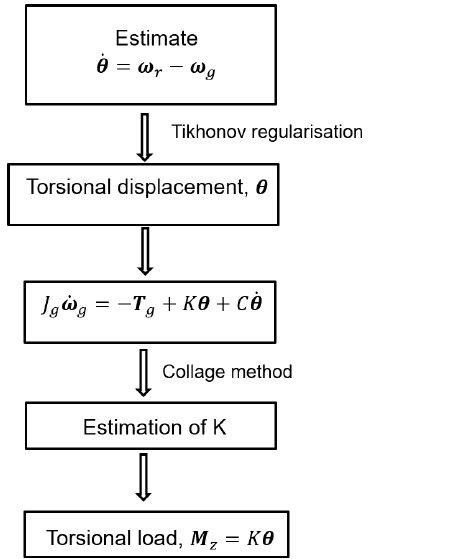
Figure 2. Flowchart depicting the inverse-problem